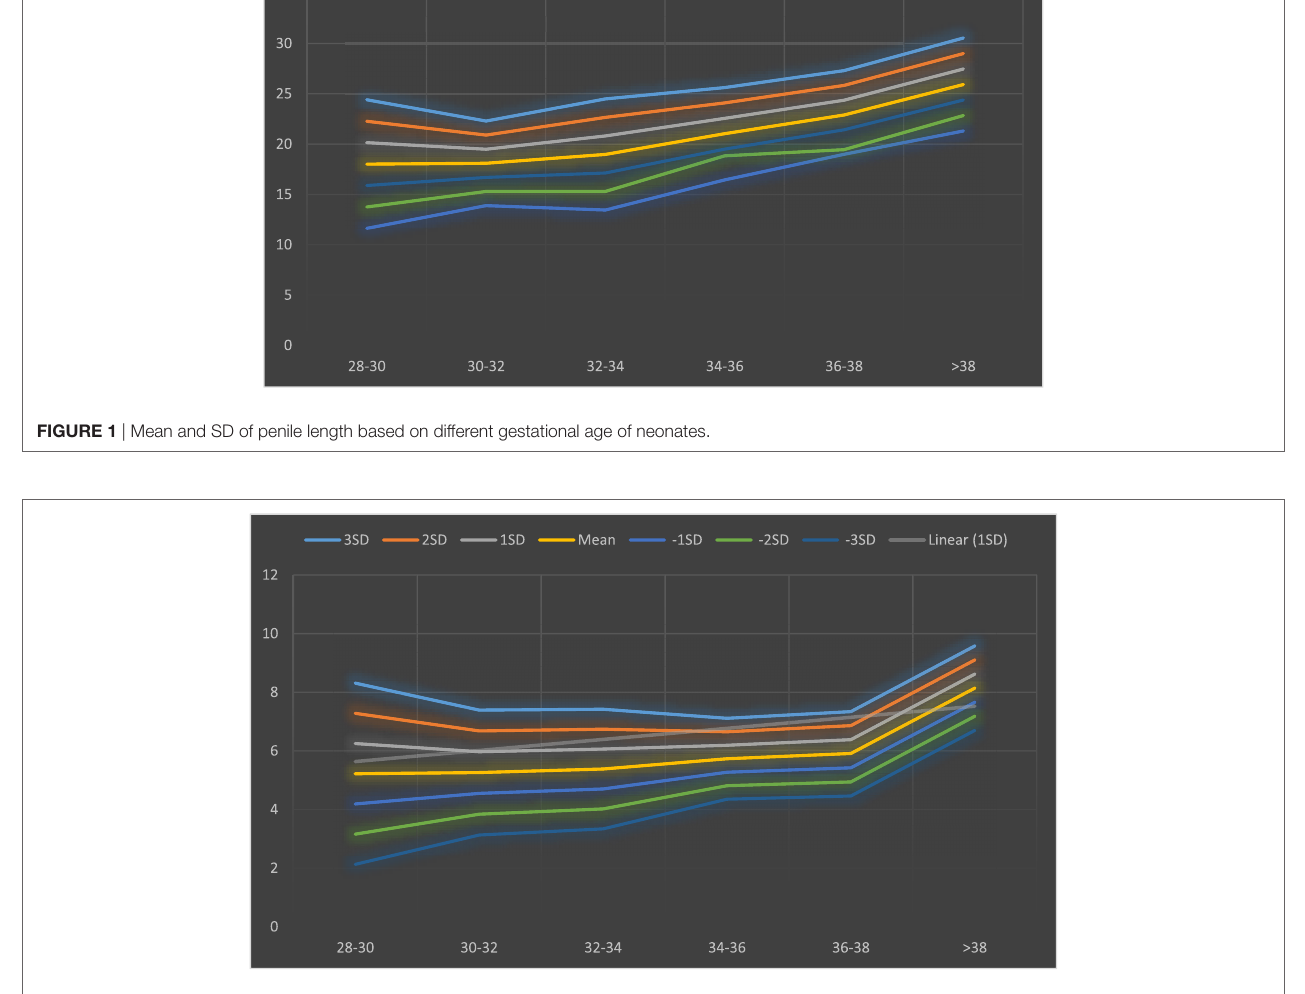
TaBle 3 | Correlation of penile length and penile circumference (PC) with other variables.